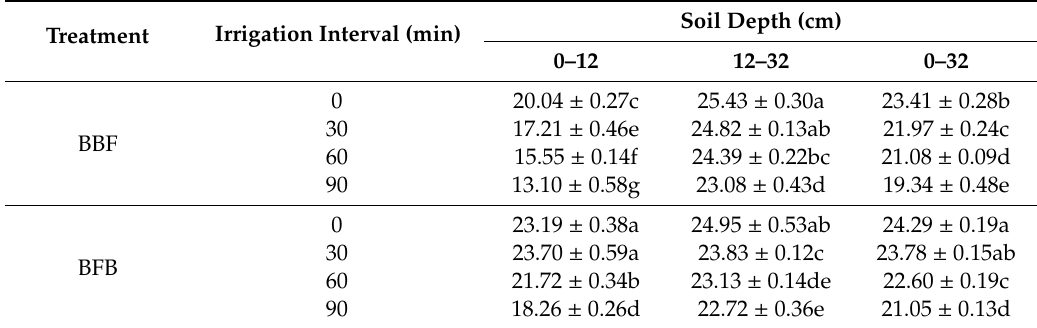
Table 4. Mean sodium adsorption ratio in the silty loam at depths of 0–32 cm under di ff erent irrigation treatments (BBF, brackish-brackish-fresh water; BFB, brackish-fresh-brackish water). Soil Depth (cm) Treatment Irrigation Interval (min) 0–12 12–32 0–32